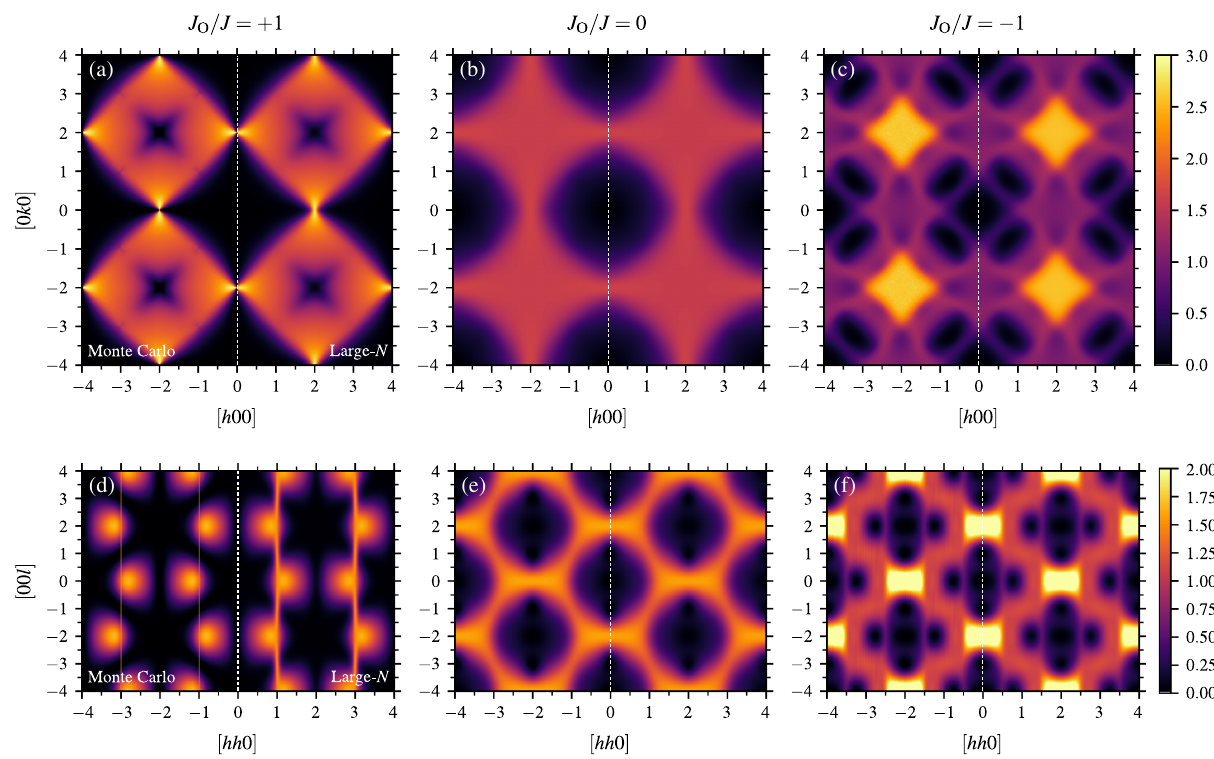
FIG. 7. Spin-spin correlation functions S ð q Þ [from large- N (right) and Monte Carlo (left)] of spin-ice films of thickness L ¼ 1 and temperature T=J ¼ 0 . 1 in the (a) – (c) ½ hk 0 (cid:3) and (d) – (f) ½ hhl (cid:3) planes. Orphan-bond values of (a,d) J J =J ¼ − 1 are shown. Monte Carlo simulations were performed with L O (effectively) in the thermodynamic limit ( L ⊥ → ∞